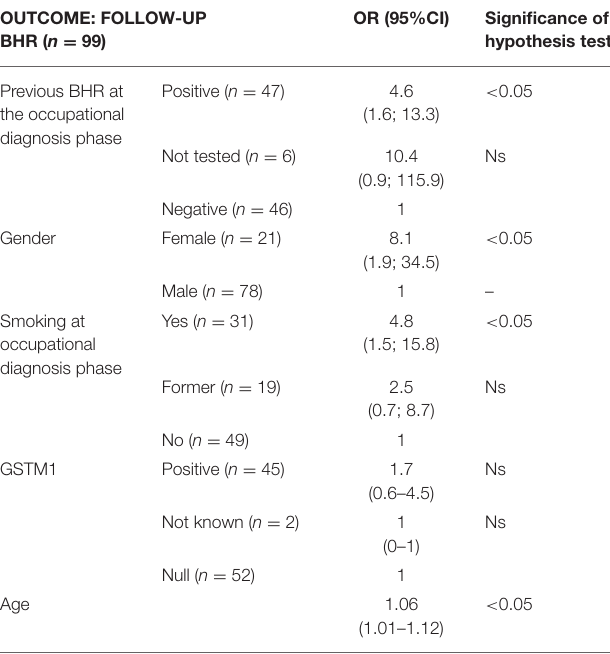
TABLE 4 | The association between BHR and putative modifying factors in a logistic regression model (non-significant factors removed). OUTCOME: FOLLOW-UP BHR ( n =